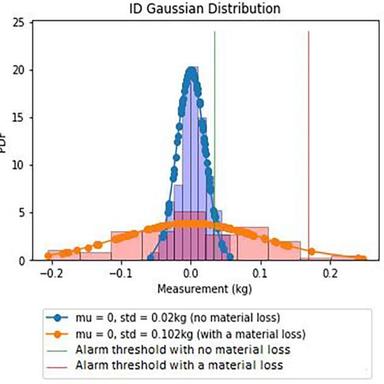
The mean for ID values is 0, and the standard deviation is 0.02 kg with no material losses, or 0.102 kg if the material loss is accounted for. Alarm thresholds for both cases were determined with the same false alarm probability of 0.05. Here, different alarm threshold values are observed due to different standard deviations associated with weight measurements.